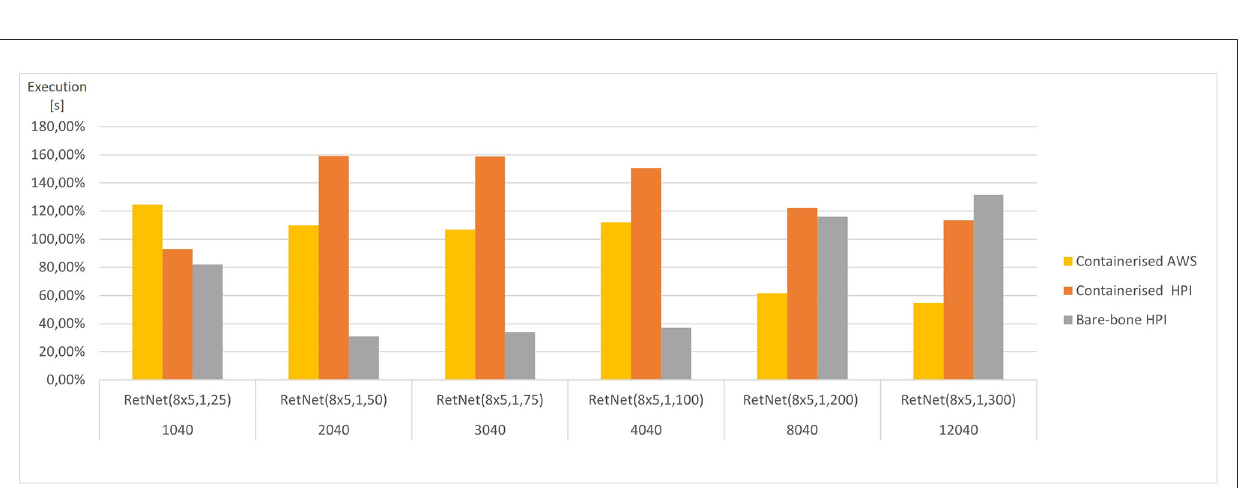
FIGURE5 Average execution (CPU time) for each RetNet model (ranging in complexity from 1,040 to 12,040 Hodgkin–Huxley neurons) viewing three input patterns (0, A, 1), expressed as a percentage of average CPU time across all execution environments for each RetNet model. Based on Tables 2,